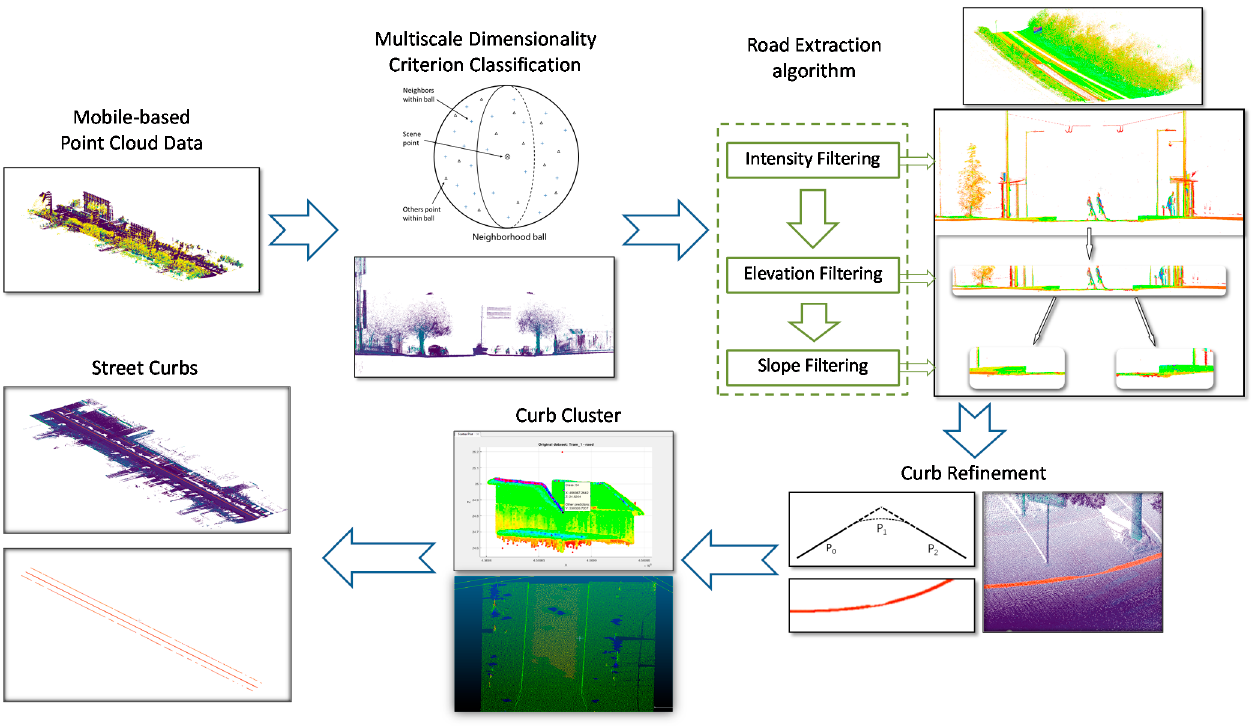
Figure 1. The procedure of the proposed method.